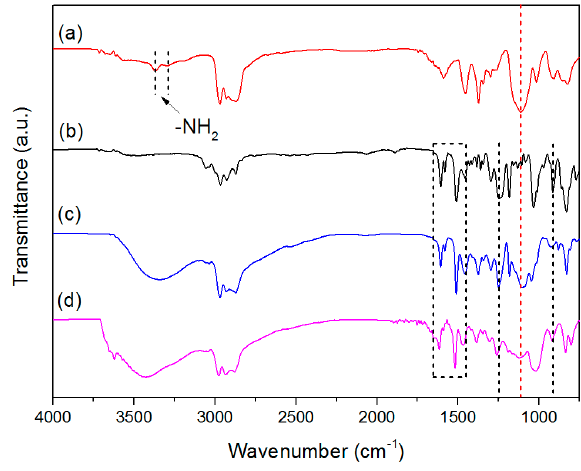
Figure 2. FTIR spectra of D400 (a) DGEBA (b), DGEBA-D400 adduct (c) and DDA-MMT (d).